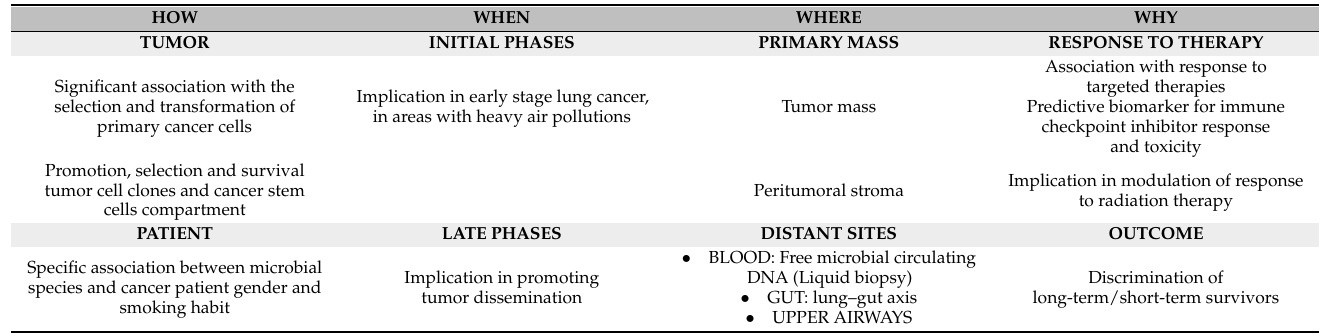
Table 1. Schematic rationale for microbiota evaluation in lung cancer. In detail, HOW the microbiome impacts the tumor itself and the patient, in which phases of tumor progression, namely WHEN the cross-talk between microbes and tumor is active, WHERE it is active (not only in tumor mass but also in distant secondary sites) and WHY it is relevant to know it, since it affects both responses to anticancer therapies and patients’